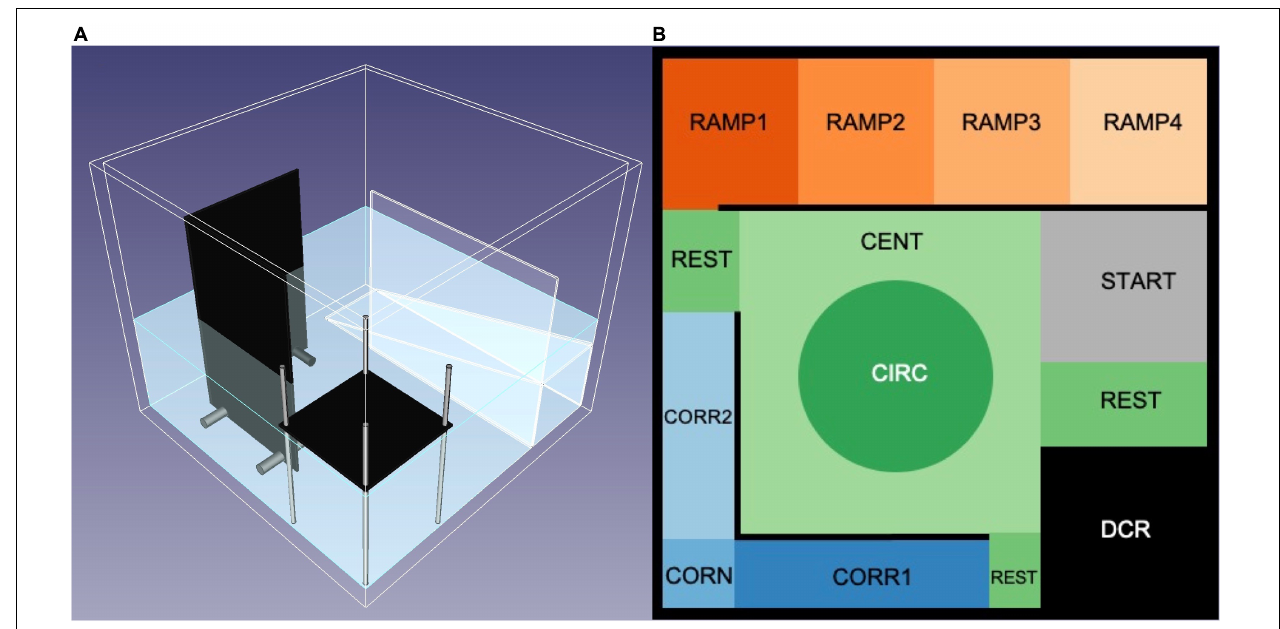
FIGURE 1 | The zMCSF testing arena. (A) 3D model of the zMCSF arena, created with FreeCAD software (Riegel et al., 2017). The zMCSF contains a dark corner roof (DCR), two walls building a corridor and corner, and an inclined ramp creating decreasing water depth, all of which surround a central open area. For exact measurements see Supplementary Material . (B) Virtual division of zones in the arena, as seen from above, used for tracking in Ethovision XT15 (Noldus, Wageningen,